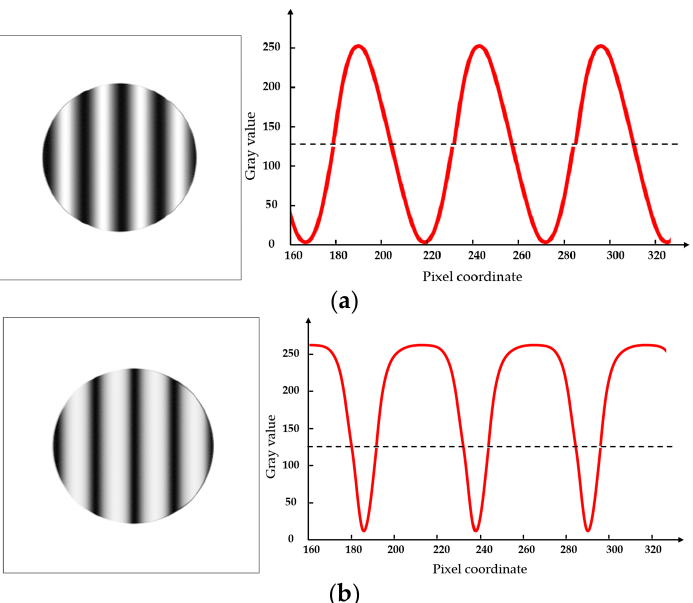
Figure 5. Interference phenomena: ( a ) two-beam interference simulation; ( b ) multi-beam interference simulation.